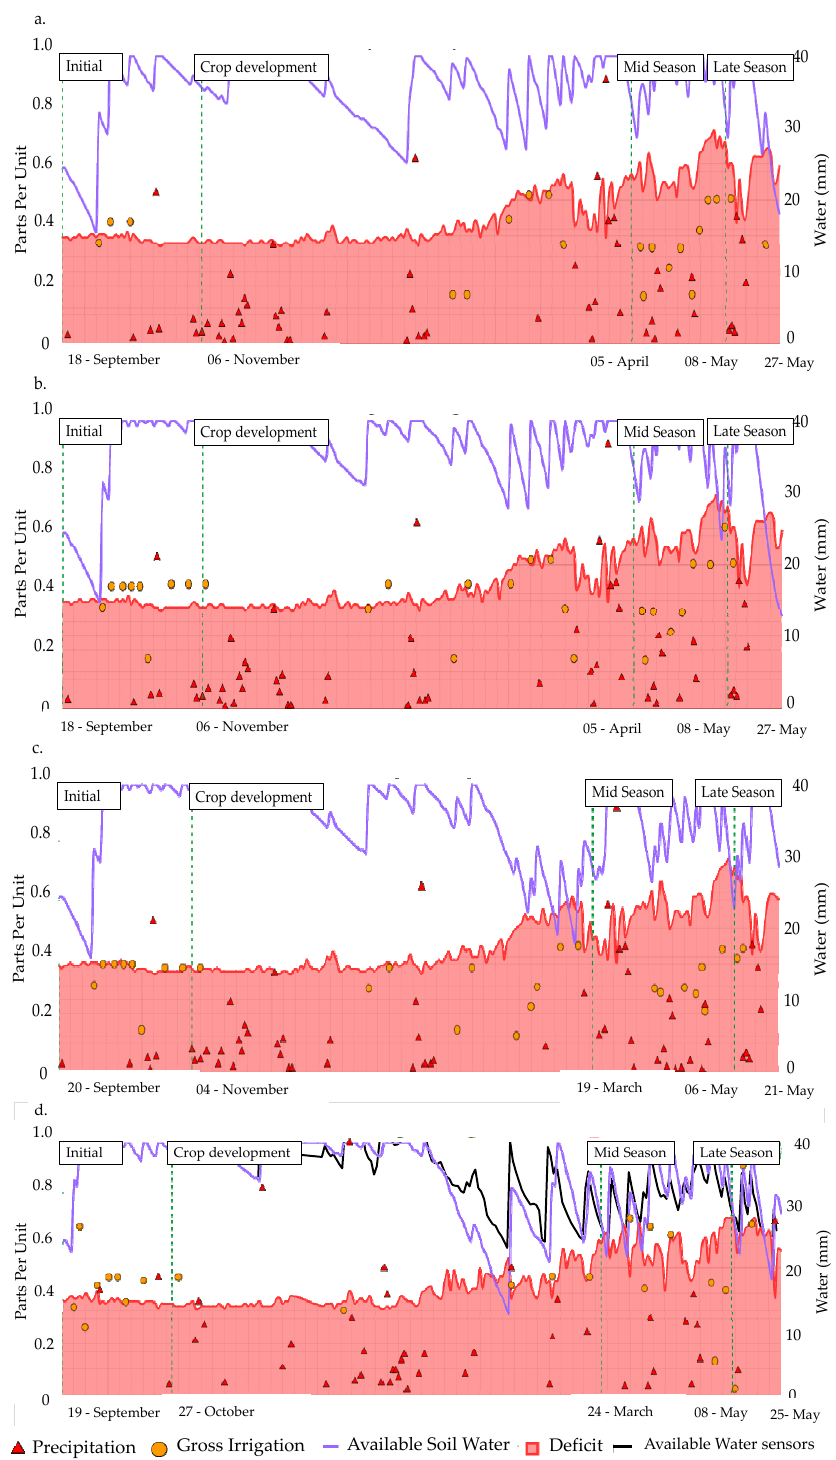
Figure 2. Evolution of available water simulated by “MOPECO irrigation scheduling” tool in 2020 for garlic crop ( a ): SUP: Supromed management; ( b ) LEA: Leader management; ( c ): AVE 1: Average management) and ( d ): Comparison with measured (Dill & Drop, Senteck: Stepney, Australia) available soil moisture progression in LEA SUP (2021) (available water sensors). Main Y axis: Deficit: 1-p, where p is the fraction of TAW (total available water) that a crop can extract without suffering water stress; available water. secondary Y axis: gross irrigation; precipitation.